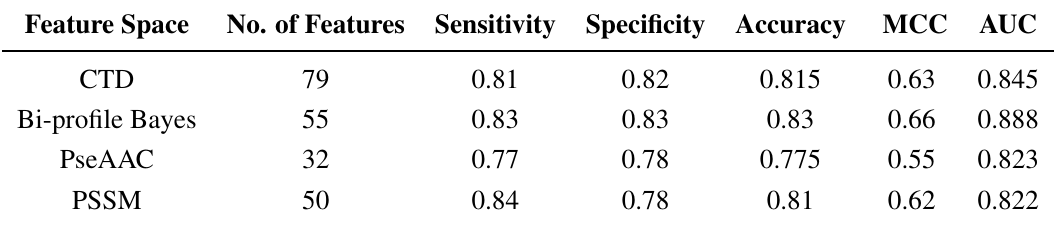
Table 2. Performance of the RF models using the individual feature spaces with feature selection on the training dataset by 10-fold